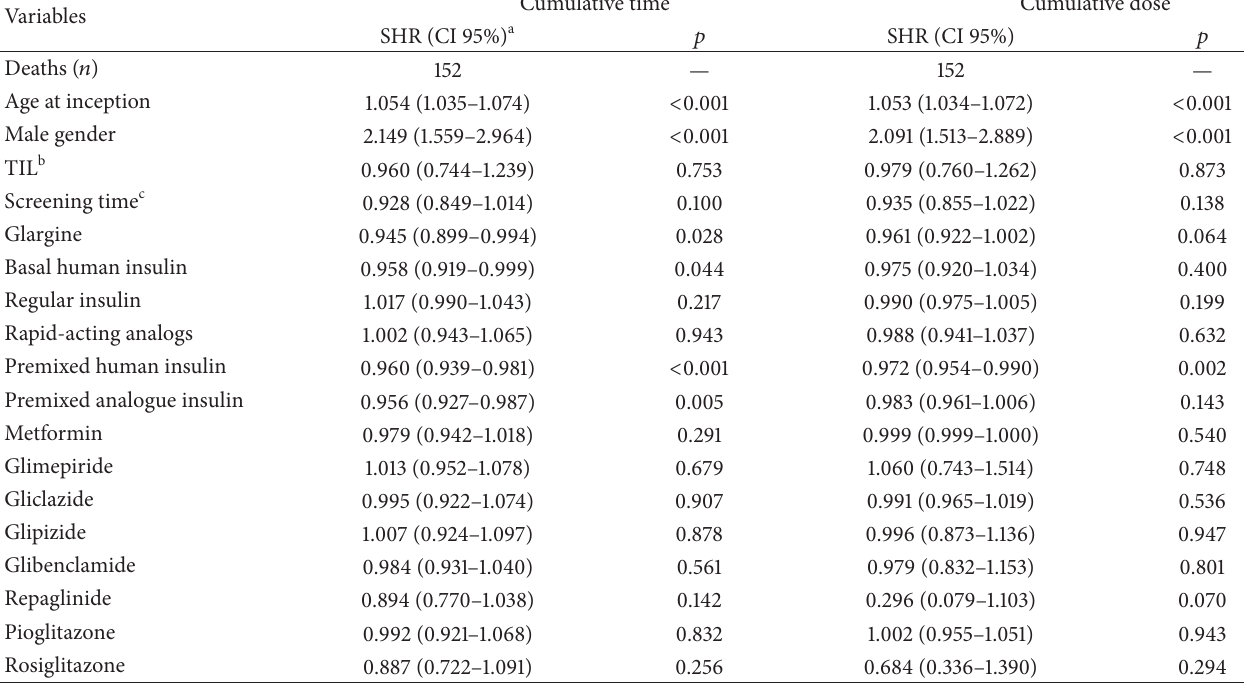
Table 1: Competing risk analysis for myocardial infarction mortality.